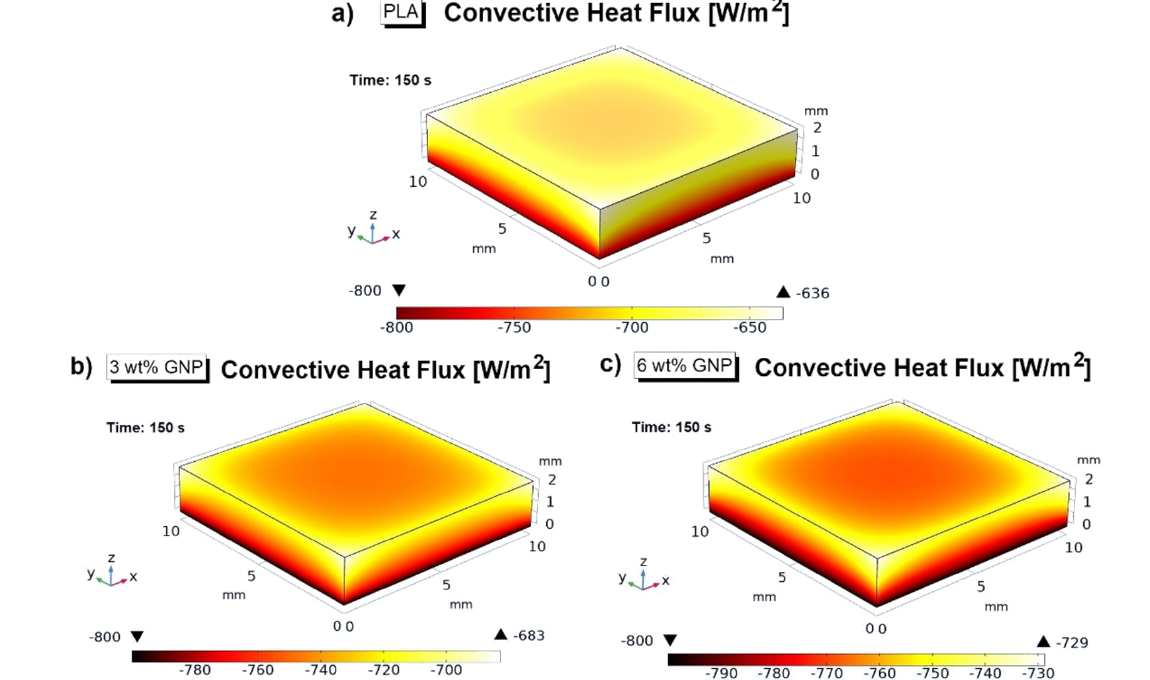
Figure 13. Three-dimensional views of the conductive heat flux at steady-state condition ( t = 150 s) and at temperature value of 373.15 K relatively to PLA, PLA/3 wt% GNPs, and PLA/6 wt% GNPs in ( a – c ), respectively.